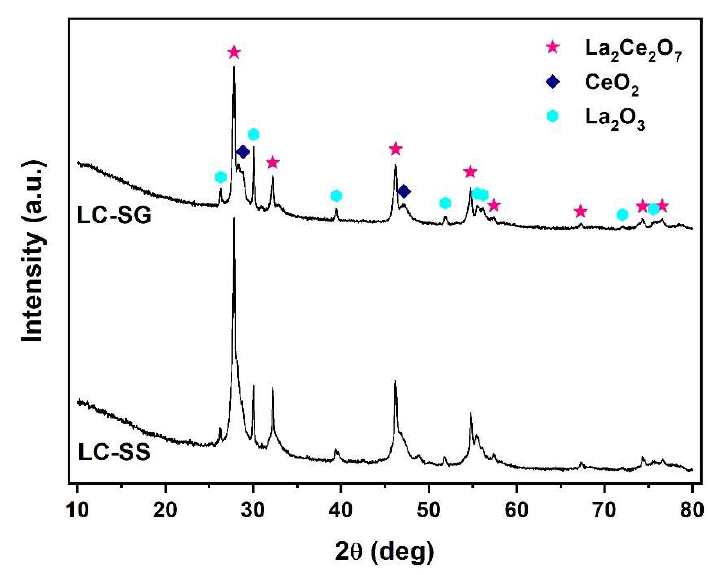
Figure 11. XRD patterns of LC particles processed by flame synthesis.